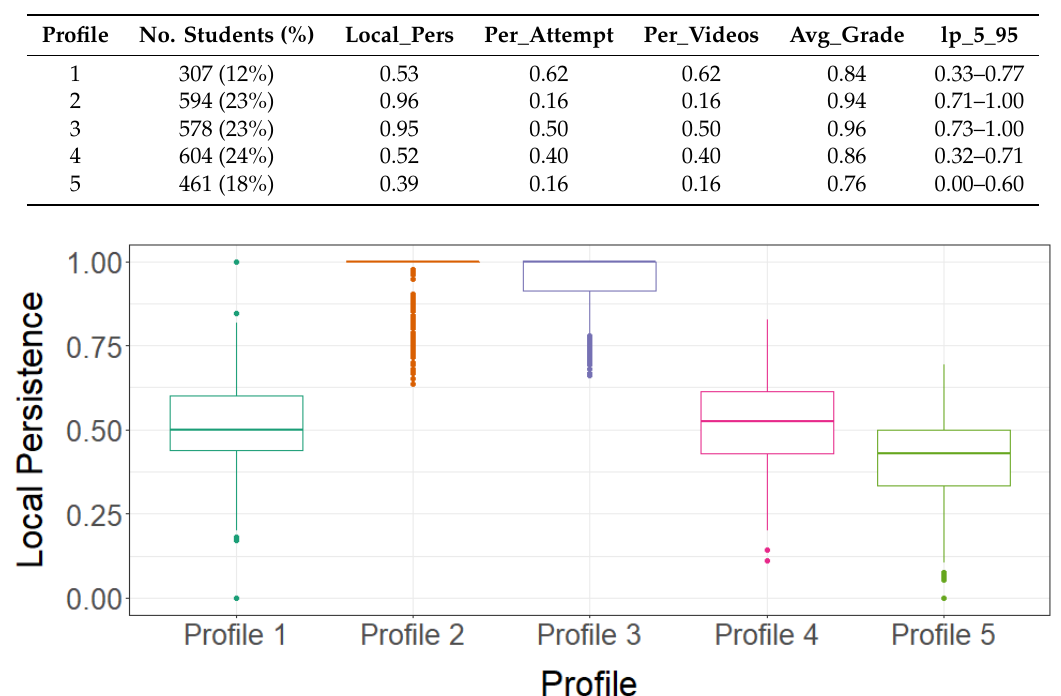
Figure 3. ( a: top-left ) Evolution of the local persistence in the first semester using all the courses, ( b: top-right ) evolution of the local persistence in the first semester for each course, where each course is a different line, ( c: bottom-left ) number of students engaging with exercises in each week of the semester for each course, ( d: bottom-right ) number of exercises students have attempted in each week of the course. Note: Actual names of the courses are omitted for confidentiality reasons.